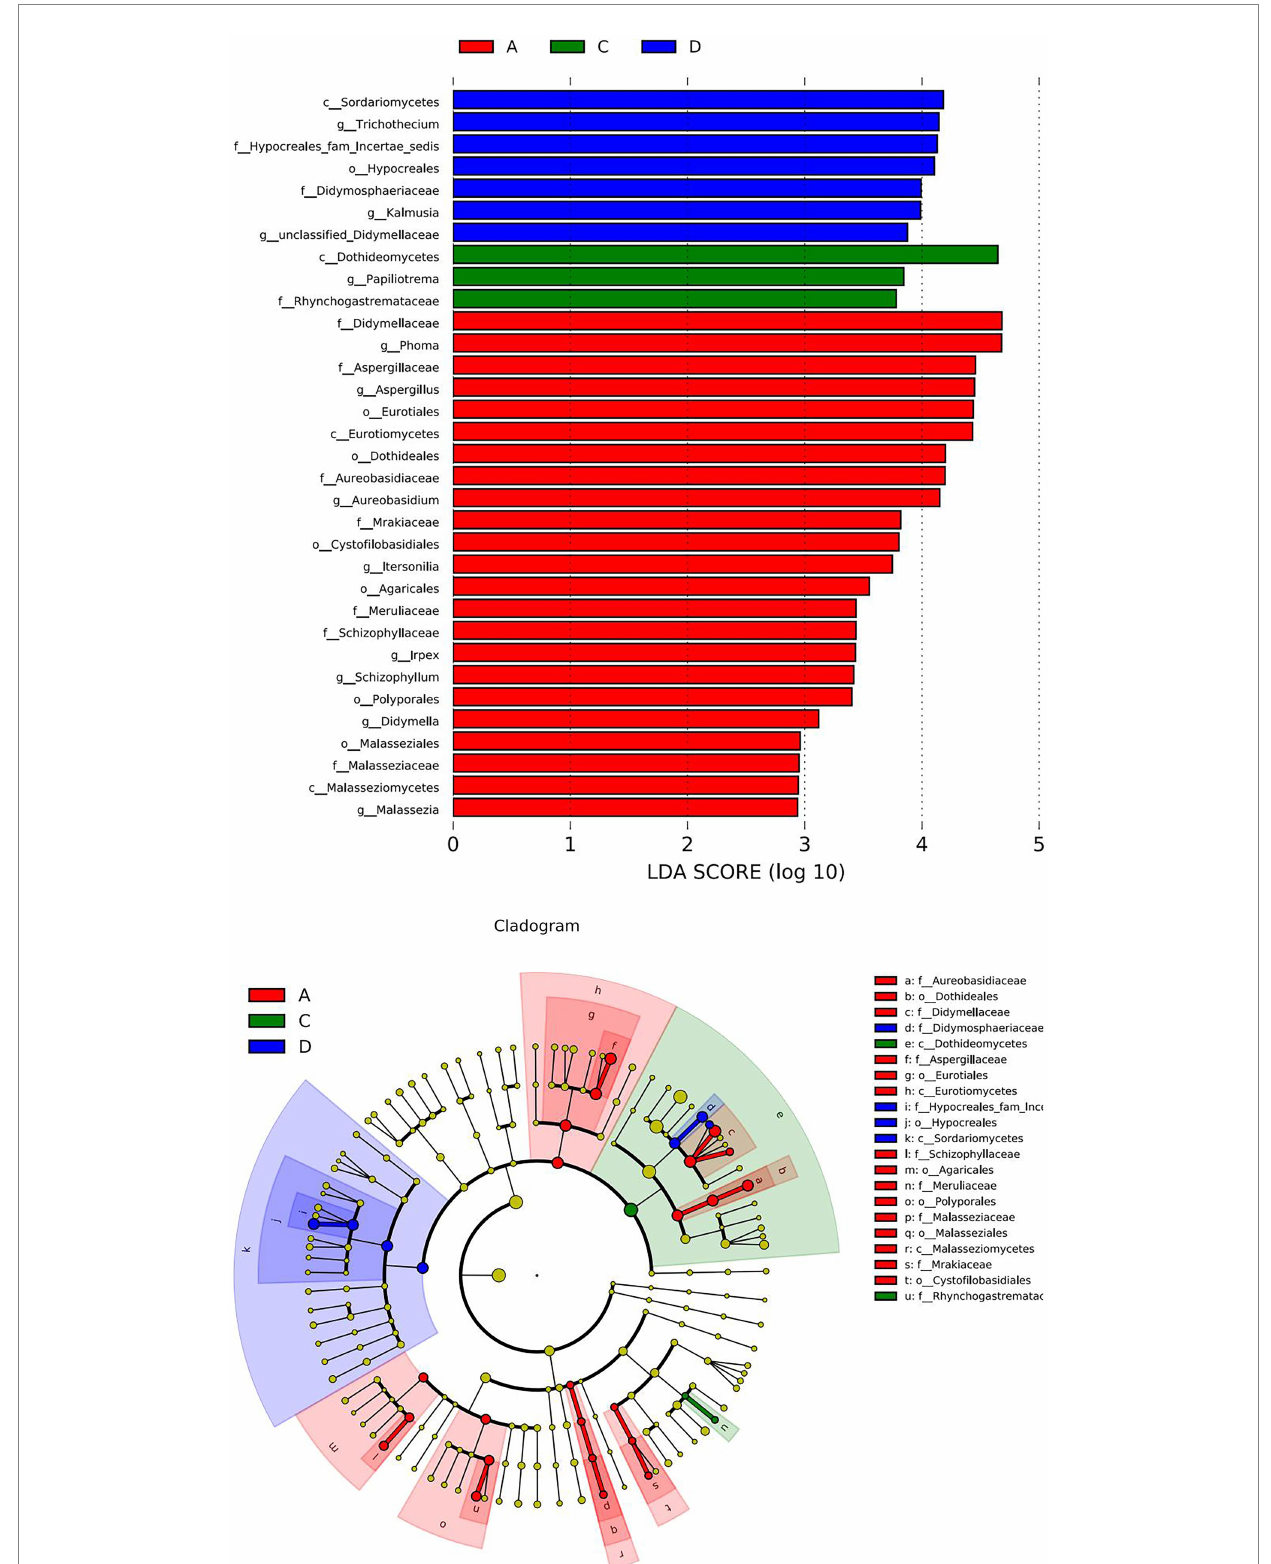
FIGURE 5 Histogram of the LDA effect values of marker species and differential taxa between groups. The LDA ordinate is a taxa with significant differences between the groups, and the abscissa visually displays the logarithmic score values of the LDA analysis for each taxa in a bar chart. The taxonomic clade shows the taxonomic hierarchical relationships of the main taxa in the sample community from the phylum to genus (from inner circle to outer circle). The node size corresponds to the average relative abundance of that taxa. Hollow nodes represent taxa with insignificant intergroup differences, while the nodes of other colors indicate that these taxa exhibit significant between-group differences and are more abundant in the grouped sample represented by that color. Letters identify the names of taxa that differ significantly between groups. LDA, linear discriminant